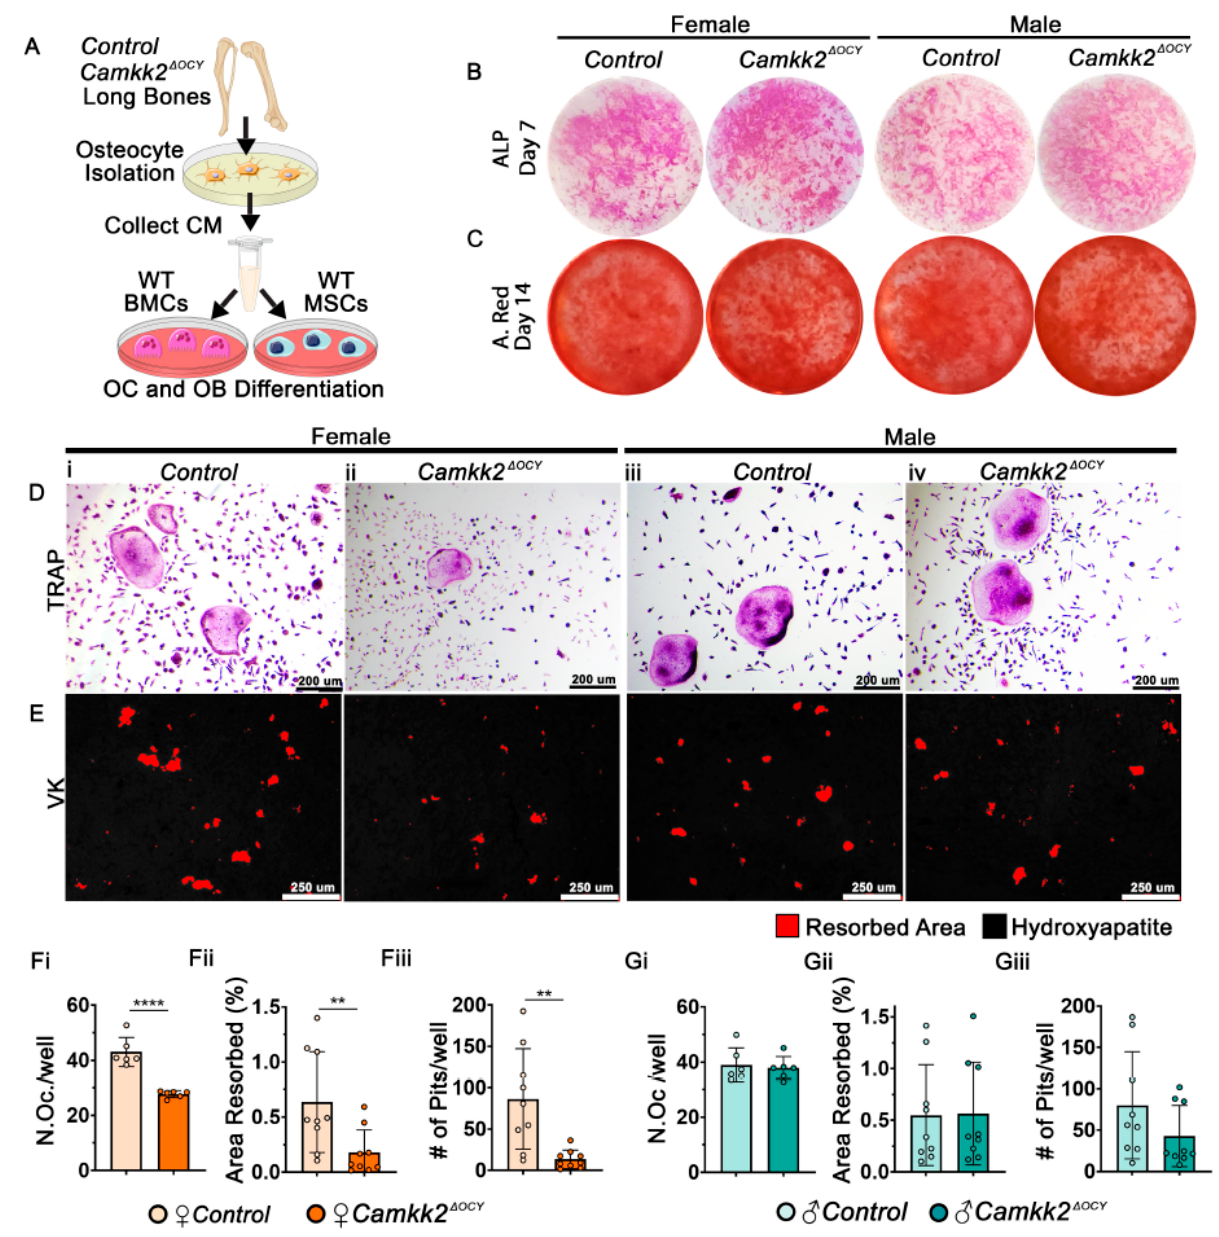
Figure 3. Conditioned media from female osteocytes lacking CaMKK2 inhibits OCs. ( A ) Schematic of in vitro experimental design for primary osteocyte isolation from long bones of individual mice and collection of osteocyte conditioned media (CM) to test OB differentiation by WT BM-derived MSCs and OC differentiation by WT BM cells (BMCs). CM from cells isolated from each mouse was kept separate and treated as a separate sample. ( B , C ) Representative images of alkaline phosphatase ( B ) and alizarin red ( C ) staining on days 7 and 14 of osteogenic differentiation, respectively ( n = 3/group). ( D ) Representative images ( n = 6/group; magnification 100x) of female and male TRAP-positive WT OCs (purple) treated with indicated osteocyte conditioned media. ( E ) Representative images ( n = 9/group) of hydroxyapatite-coating (black) stained with Von Kossa (VK) to reveal areas of osteoclast-mediated resorption pits (pseudo-colored red). ( Fi , Gi ) Enumeration of TRAP-positive osteoclasts with ≥ 3 nuclei, ( Fii , Gii ) percent area resorbed and ( Fiii , Giii ) total number of pits measured using ImageJ. Error bars represent SD. ** p < 0.01, **** p < 0.0001. 2.4. Extracellular Calpastatin is Enriched in Female CaMKK2-Deficient Osteocyte Conditioned Media Compared to Control and its Sequestration Relieves OC Inhibition It is well documented that osteocytes regulate OC differentiation through the altered expression of receptor activator of nuclear factor κ -B ligand (Rankl) and Opg [20,21].